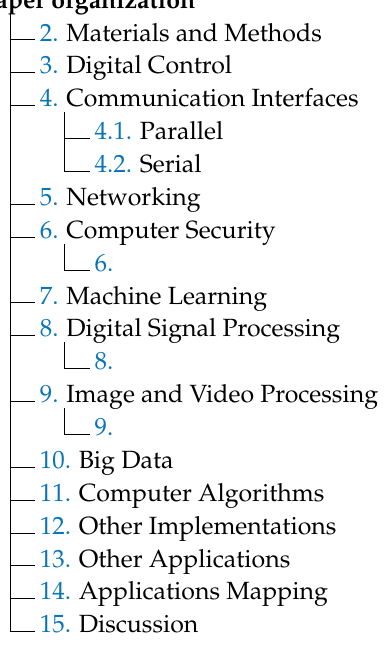
Figure 1. Organization of the